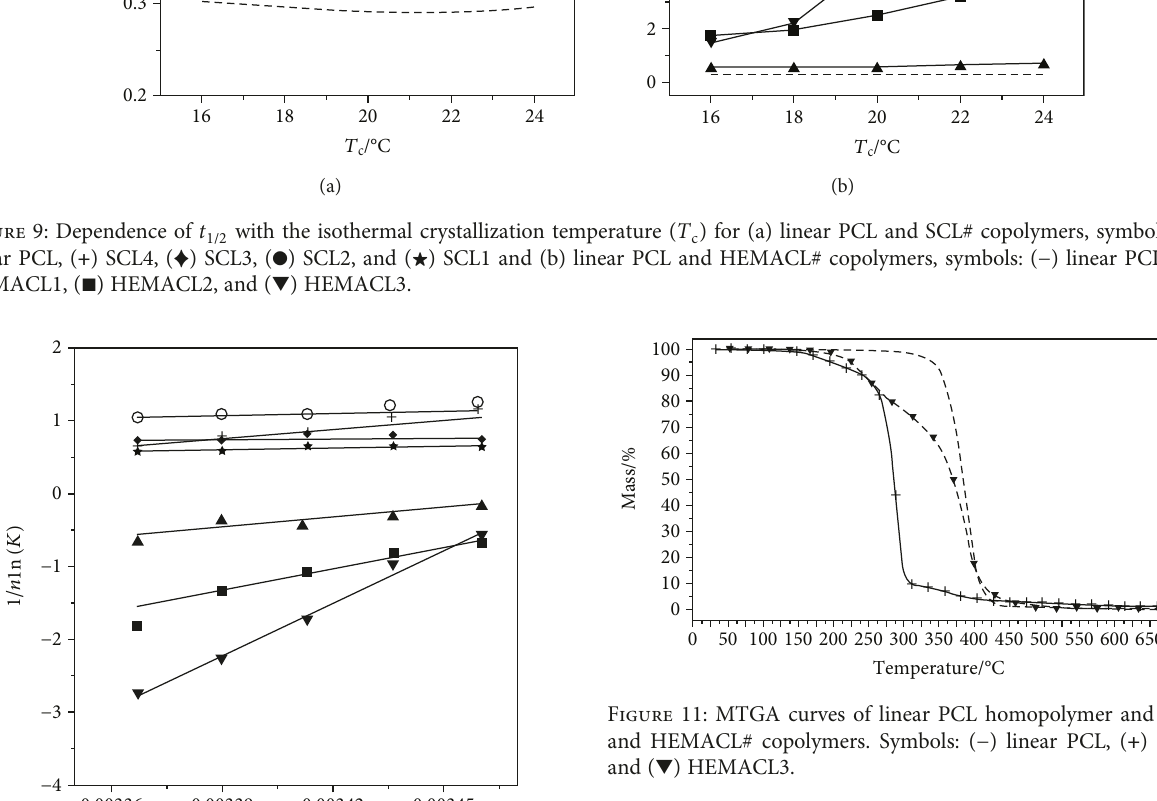
for linear PCL c